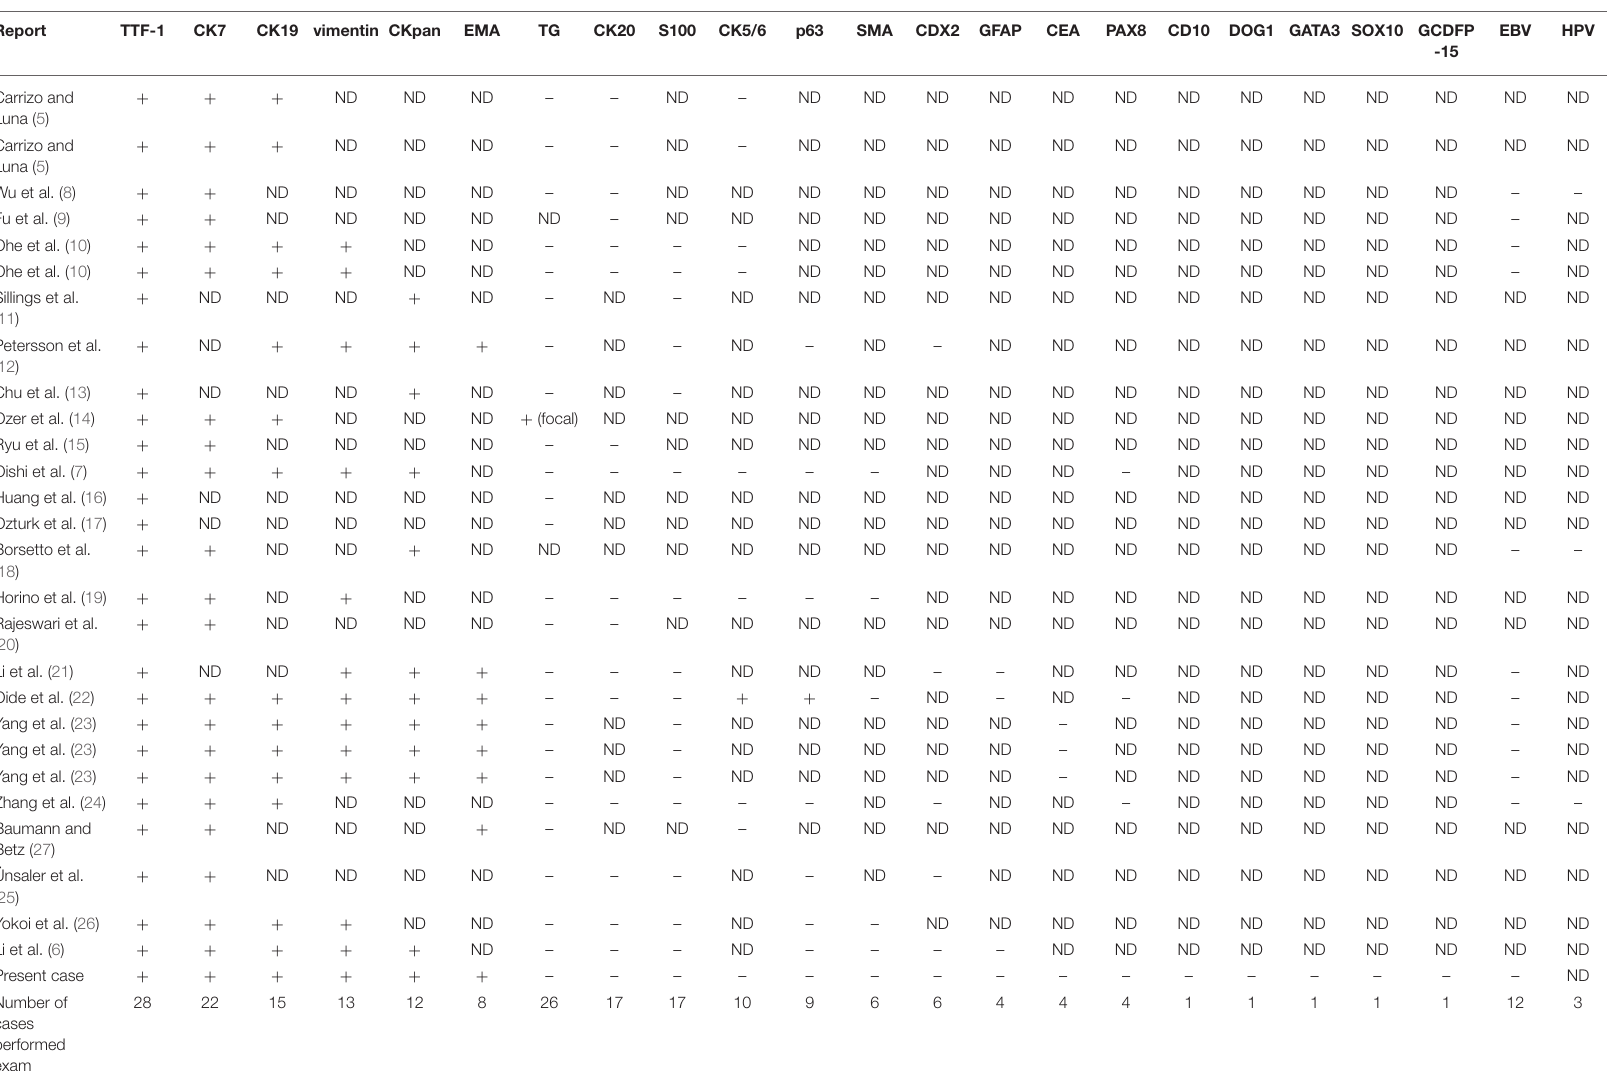
TABLE 2 | Summary of characteristics of immunohistochemical and in situ hybridization investigations of previously reported thyroid-like low-grade nasopharyngeal papillary